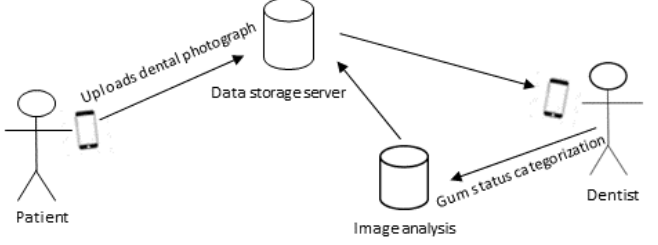
Figure 1. Interaction between the user, app administrator, and data storage server.